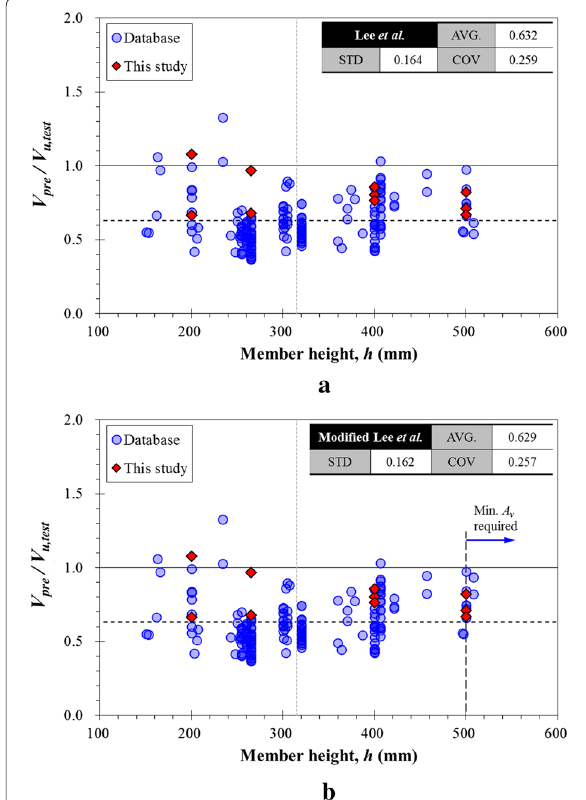
Fig. 14 Verification of alternative approache. a Eq. 5, b Eq. 5 with consideration on thick members (h > 500